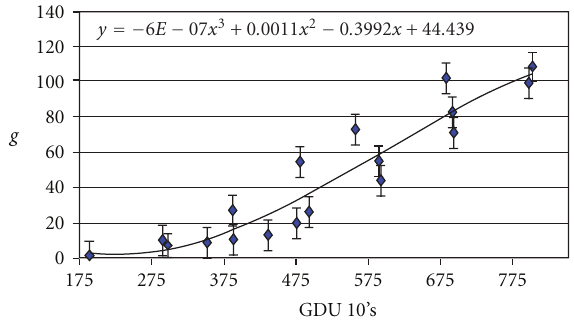
Figure 3: Leaf Area Index Development of Six Corn Hybrids (Four Glyphosate Resistant, One Glufosinate-Ammonium Resistant, and one Atrazine Resistant) Grown at Stoneville, MS in 2007 and Treated with Herbicides or Cultivated for Weed Control.